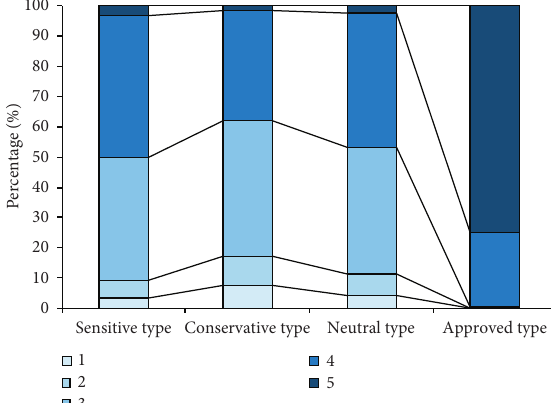
Figure 7: PE of drivers in the four segments.